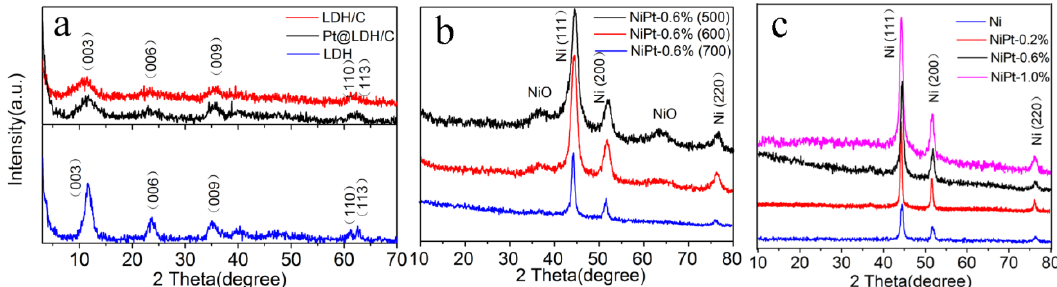
Figure 1. X-ray diffraction (XRD) patterns of ( a ) layered double hydroxide (LDH), LDH/carbon (C), and Pt@LDH/C; ( b ) NiPt catalysts obtained at different calcination temperatures; and ( c ) the Ni and NiPt catalysts with different Pt loadings.